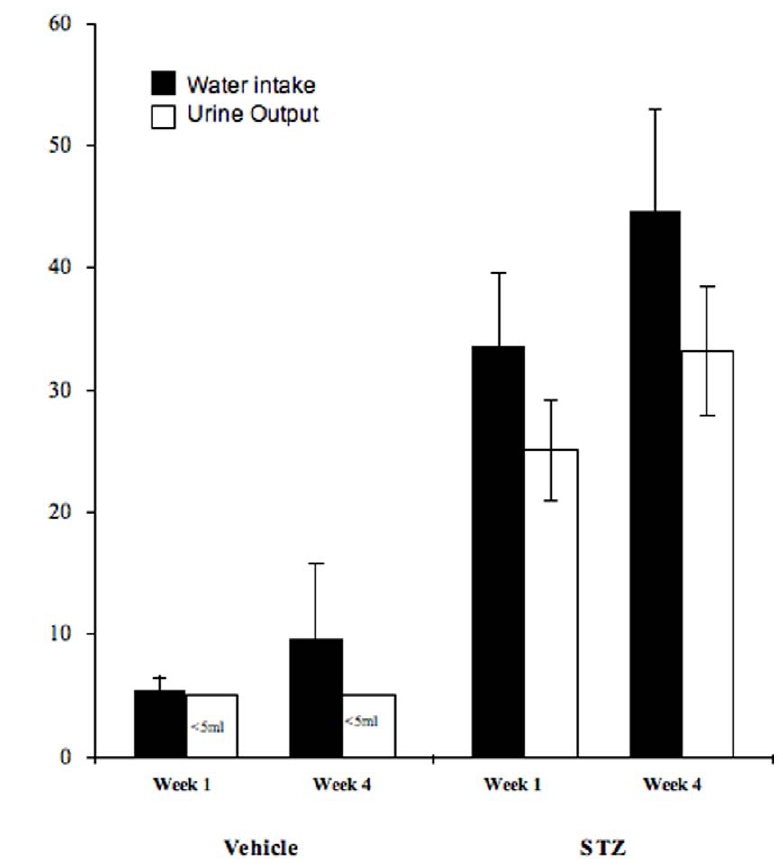
Figure 2. Water flux of VEH and STZ mice. Average water intake ( & ) and urine output ( % ) from VEH treated (n=6) and STZ treated mice (n=6), at 1 week and 4 weeks post-injection. Bars delineate standard deviation within each group. Urine output from VEH treated mice was less than 5ml/ day and below measurement precision.